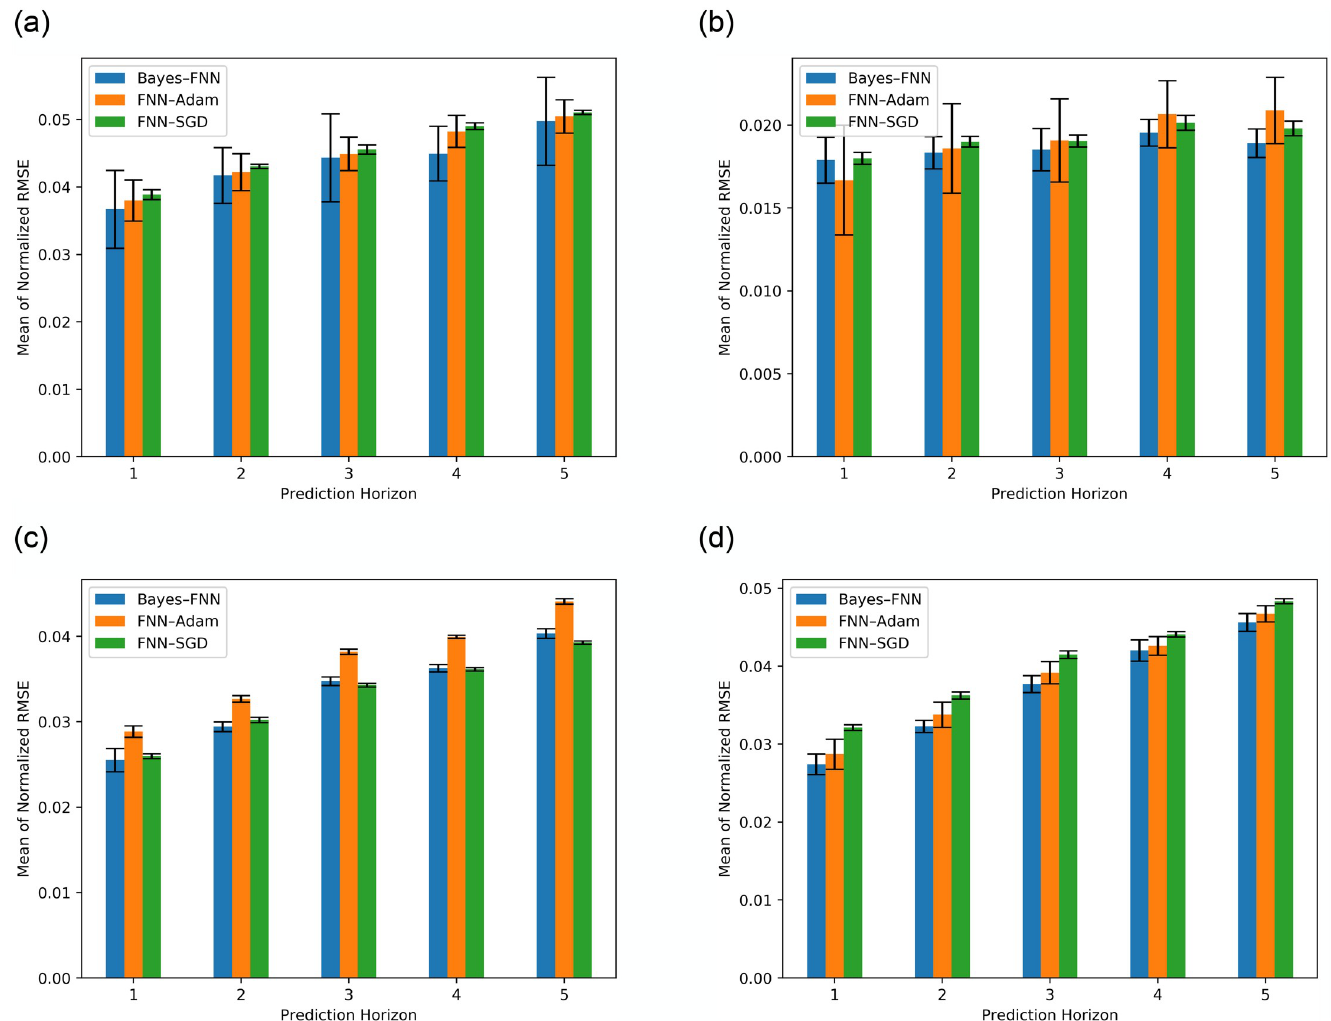
Fig 4. Prediction performance (mean of normalized RMSE) for the three models (Bayes-FNN, FNN-Adam, and FNN-SGD). Note that the predictions were normalized in range of [0, 1].